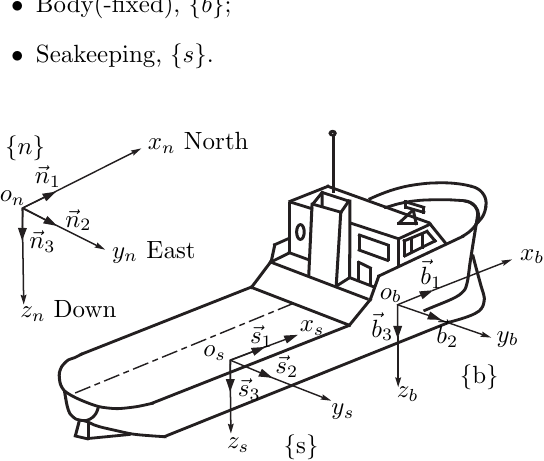
Figure 2: Coordinate systems and relative